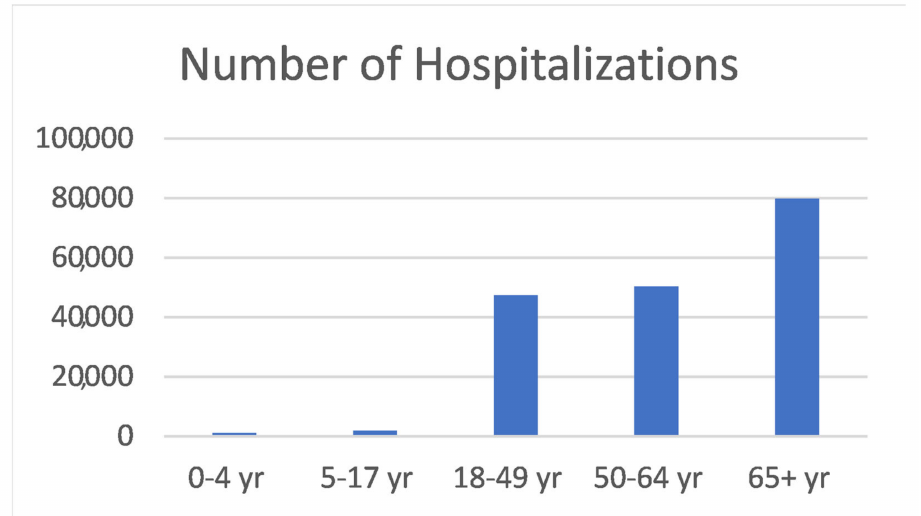
Figure 1. Number of COVID-19-associated hospitalizations for the period of 7 March 2020–22 May 2021 in the USA, categorized by age group. Source: US CDC https://gis.cdc.gov/grasp/covidnet/ COVID19_5.html, accessed on 5 June 2021.